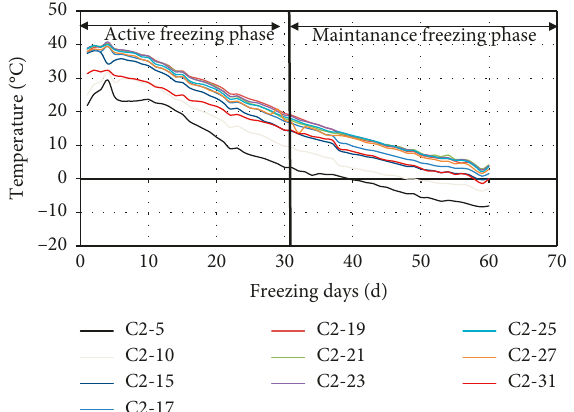
Figure 9: Curves of temperature and times at C2 temperature measuring hole.